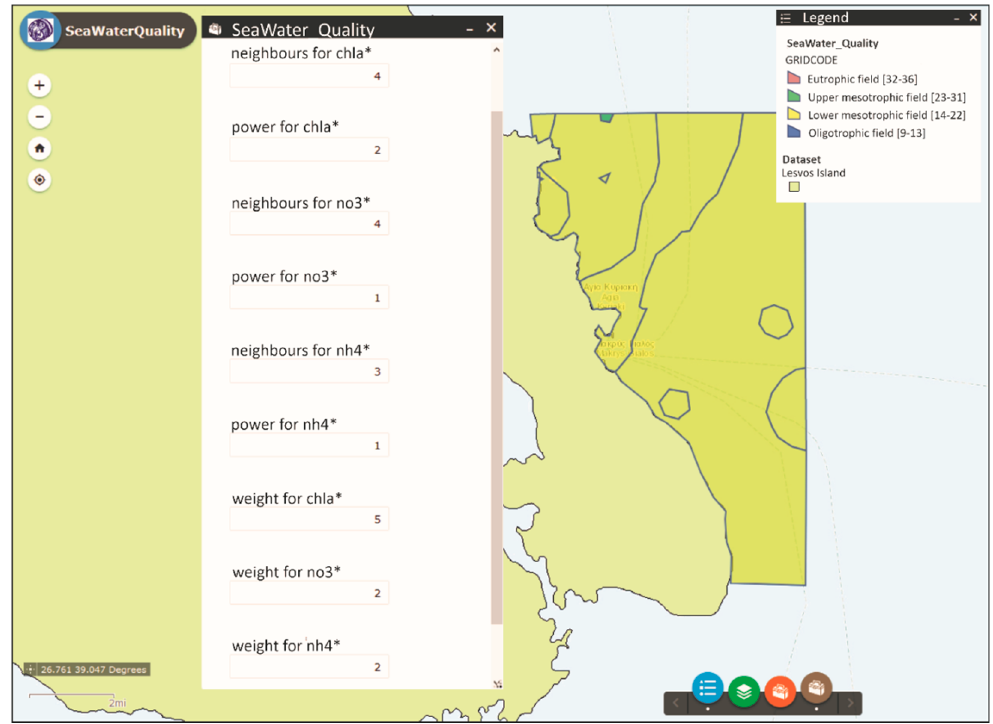
Figure 5. Spatial distribution of the eutrophication levels in the Strait of Mytilene when higher weight was assigned to chla. (The * indicates that these fields must be filled in by the user).